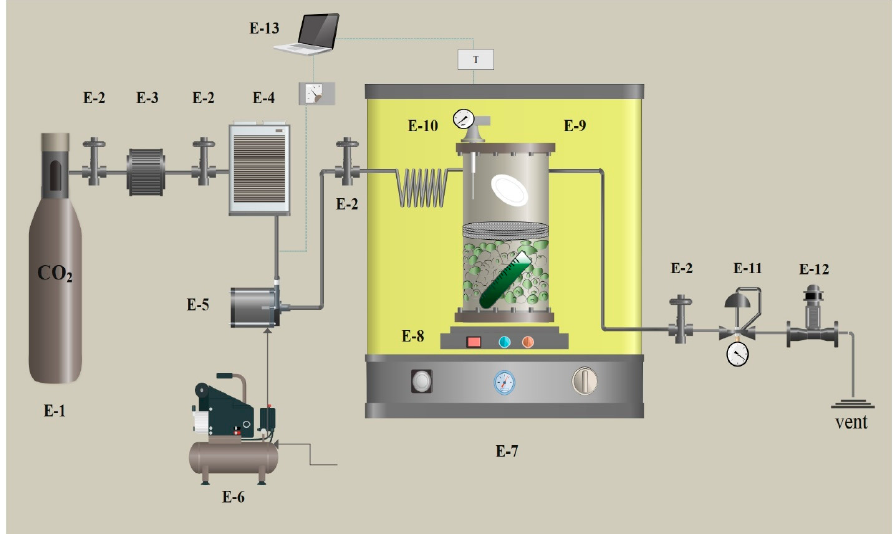
Figure 2. Schematic representation of the SC-CO 2 -assisted impregnation apparatus. E-1: CO 2 cylinder, E-2: Needle valve, E-3: Filter, E-4: Refrigerator unit, E-5: High-pressure pump, E-6: Compressor, E-7: Oven, E-8: Magnetic stirrer, E-9: Impregnation cell, E-10: Pressure gauge, E-11: Micrometering